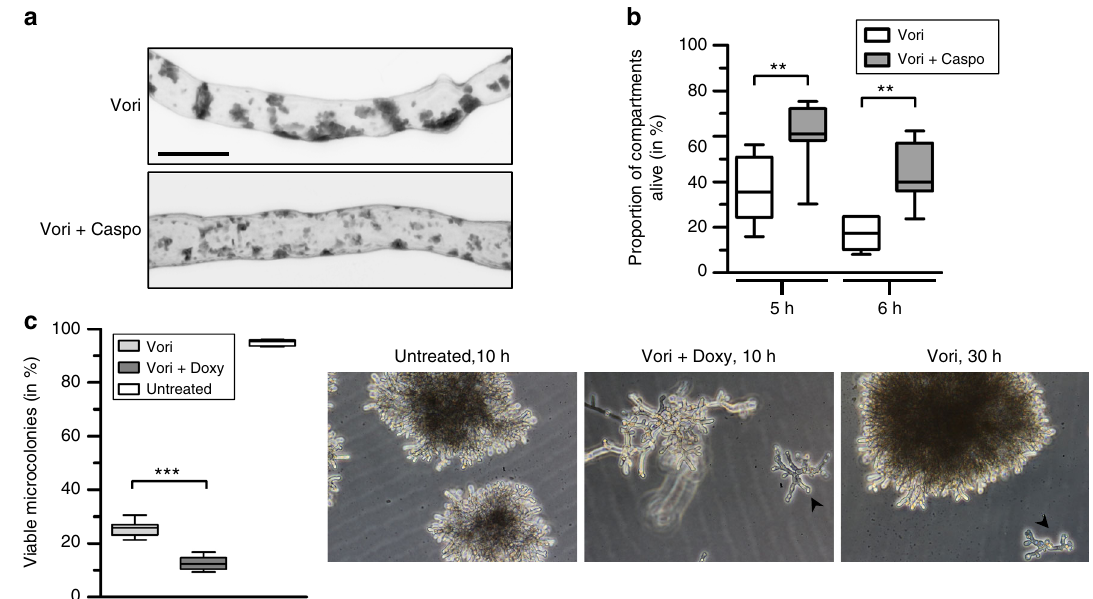
Fig. 8 Inhibition of β -1,3-glucan synthesis attenuates the fungicidal activity of voriconazole. a , b Conidia of A . fumigatus wild-type ( a ) or wild-type expressing mitochondria-targeted GFP ( b ) were inoculated in Sabouraud medium on cover slips ( a ) or in an eight-well live cell microscopy slide ( b ) and incubated at 37 °C. After 9 h incubation, medium was supplemented with 1.27 µ g ml − 1 voriconazole (Vori) and, when indicated, 30 min later additionally with 4 µ g ml − 1 caspofungin ( + Caspo). a After 4 h co-incubation with antifungals, hyphae were fi xed, stained with calco fl uor white and analyzed with a confocal laser scanning microscope. Depicted are representative calco fl uor white fl uorescence images of optical stacks that cover the entire hypha in focus. Bar represents 10 μ m and is applicable to both subpanels. b After 5 and 6 h co-incubation with antifungals, the mitochondrial morphology and dynamics of at least 975 hyphal compartments per condition were analyzed with a confocal laser scanning microscope in seven independent experiments. The box-and-whiskers graph shows the percentage of viable compartments under each condition. Statistical signi fi cance (** p < 0.01) was calculated with a two-tailed paired Student ’ s t -test (assuming equal variances). c Conidia of the conditional β -1,3-glucan synthase mutant ( fks1 tetOn ) were inoculated in Sabouraud medium in 24-well plates and incubated at 37 °C under repressive conditions for 11 h. When indicated, media were subsequently supplemented with 1.27 µ g ml − 1 voriconazole (Vori), or additionally with 10 µ g ml − 1 doxycycline (Vori + Doxy) to induce expression of the β -1,3-glucan synthase Fks1. After additional 6 h incubation at 37 °C, medium was discarded. The wells were washed and supplemented with fresh medium without antifungals and doxycycline and the plates incubated for additional 10 to 30 h at 37 °C. The percentage of surviving microcolonies was microscopically determined and shown in the depicted box-and-whiskers graph. Criteria for viability were continuation of growth combined with light refraction; viable hyphae were bright, shown on the right, dead microcolonies are indicated with arrow heads. The depicted experimental results are representative of four independent